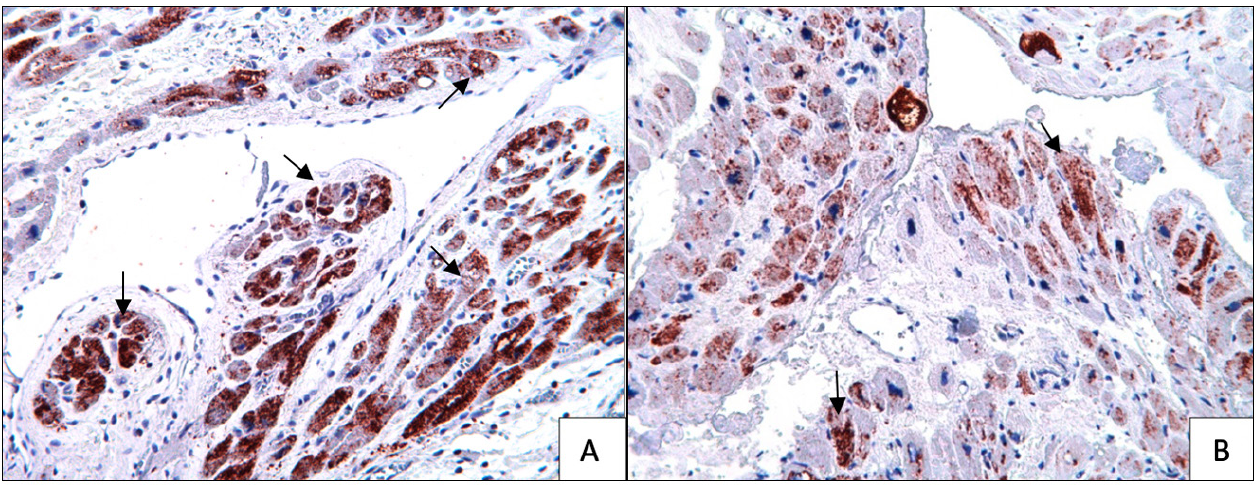
Fig. 5 - Bcl-2 immunostaining of Custodiol (A) versus blood cardioplegia (B) samples, 20X. (A) Bcl-2 immunostaining is very intense in this section. Custodiol group, 20X. (B) Bcl-2 immunostaining is weak or moderate in this section. Arrows: Bcl-2 stained